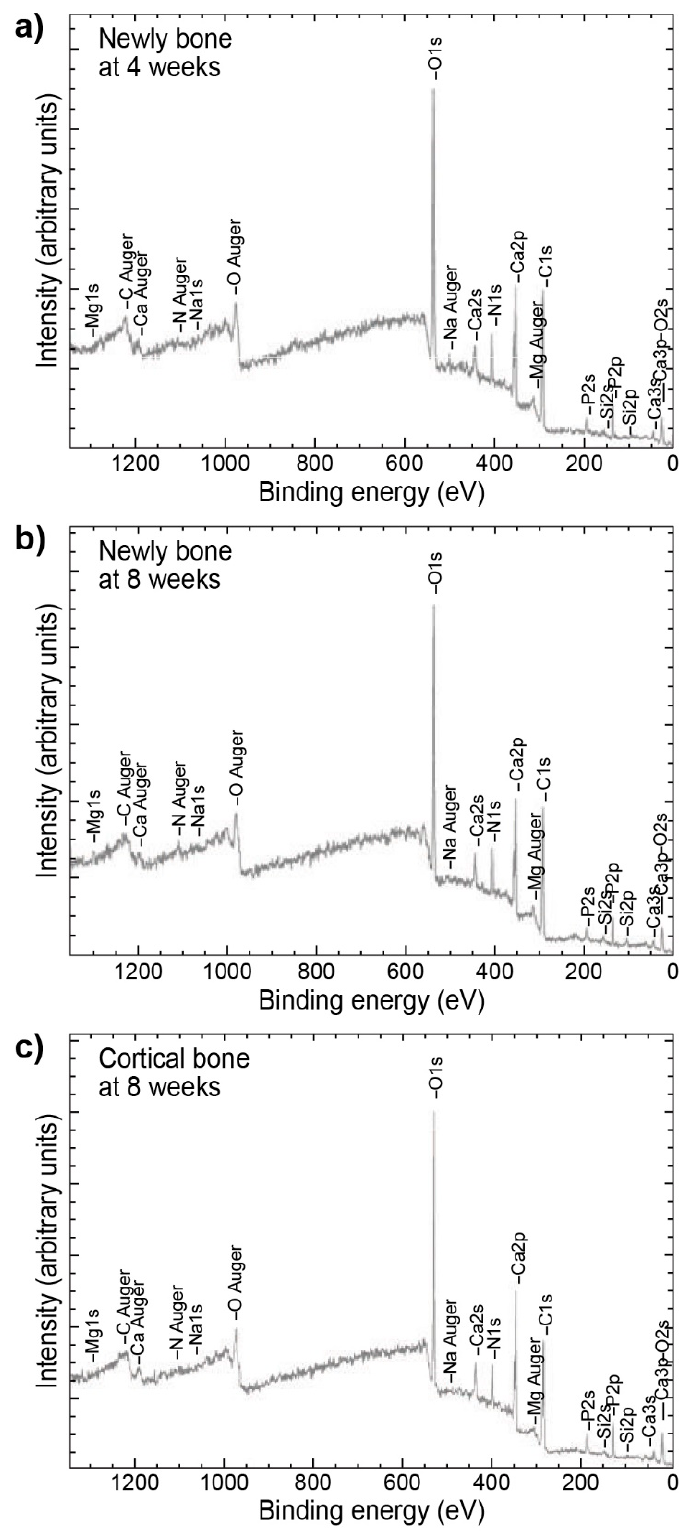
Figure 6. XPS spectra of newly formed bone after ( a ) four weeks, ( b ) eight weeks in the proximity of the titanium implant, and ( c ) cortical bone, as a control. Figure adapted with permission from [52].